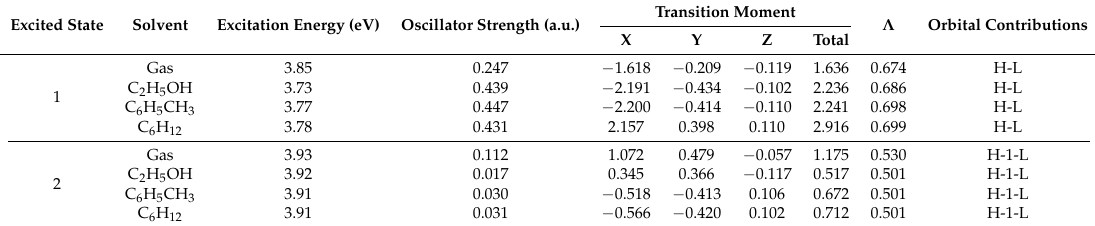
Table 3. Excitation energy, oscillator strength, transition moment, lambda value, and the contributing orbitals for the first two transitions of D-luciferin in gas, ethanol, toluene, and cyclohexane solvents. Excited State Solvent Excitation Energy (eV) Oscillator Strength (a.u.)